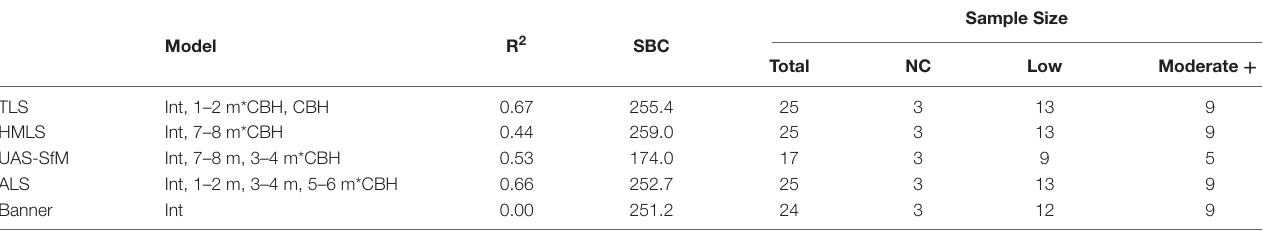
TABLE 5 | GLM model results using continuous